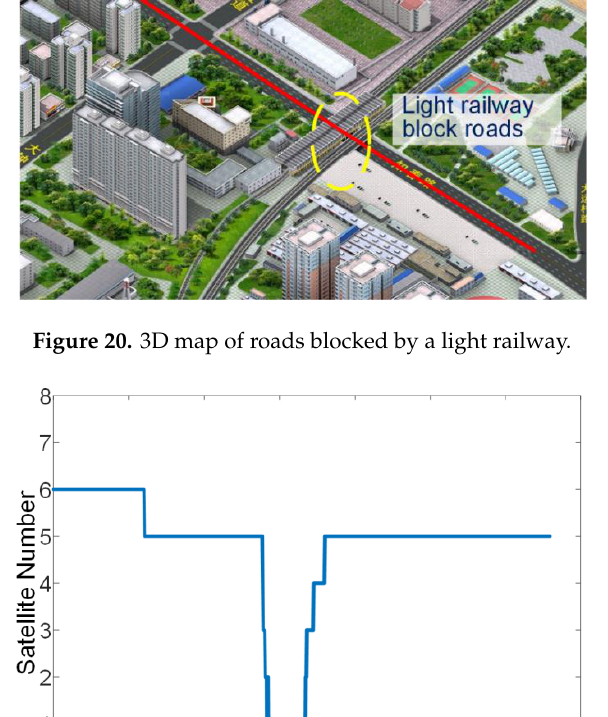
Figure 20. 3D map of roads blocked by a light railway.